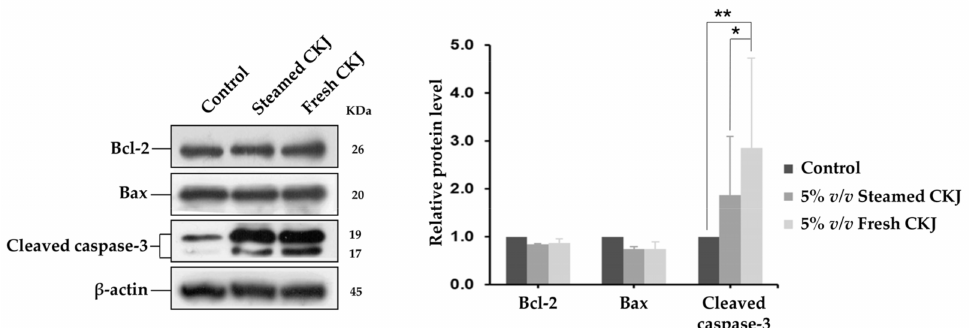
Figure 4. Western blot analysis for cleaved caspase-3, Bcl-2, and Bax using lysates from U937 cells exposed to fresh and steamed CKJ for 72 h ( left ). The graphs show the densitometric analysis, normalized against β -actin ( right ). (* p = 0.05 and ** p = 0.01). Data are representative of at least three independent